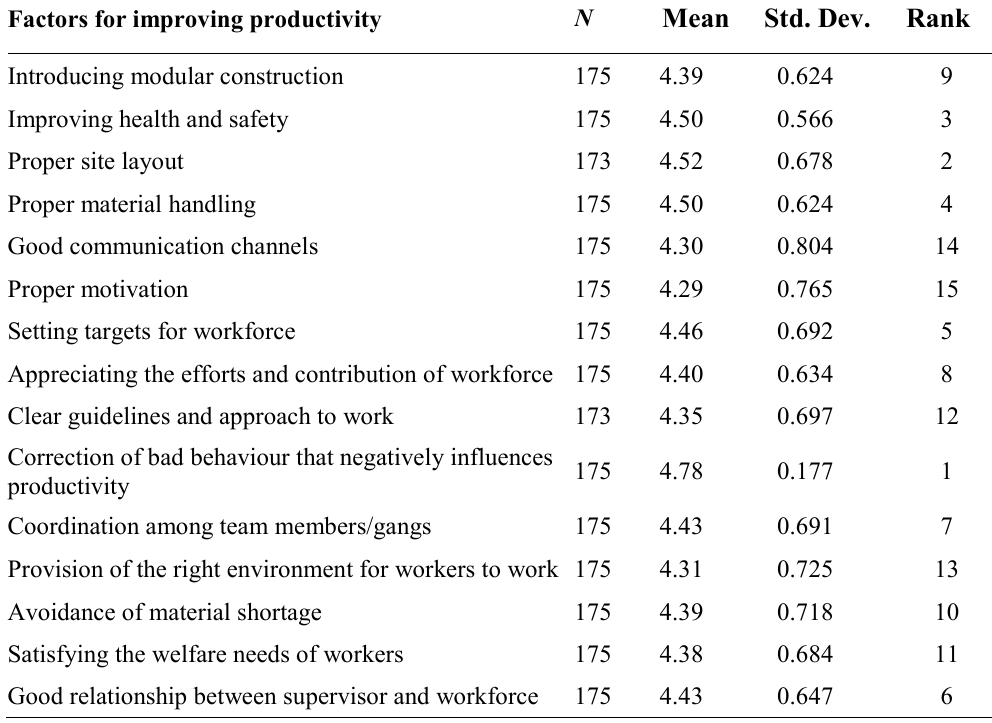
Table 3. Ways of Improving Labour